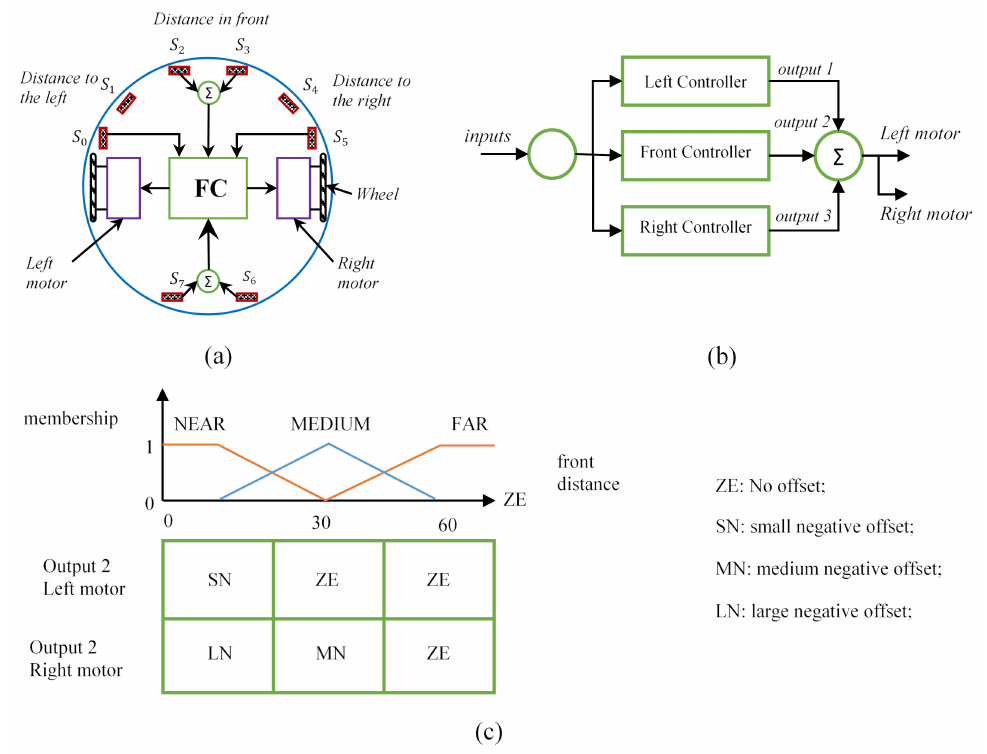
Figure 12. Usage of fuzzy logic control: ( a ) multiple sensor setup with ( b ) the structure of the fuzzy controller. ( c ) Fuzzy control rules for steering away from front obstacles